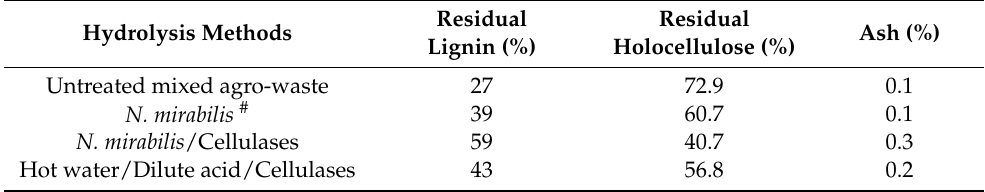
Table 3. Residual lignin and holocellulose content of the untreated N. mirabilis plant digestive fluids/cellulases and hot water/dilute acid/cellulases hydrolysed agro-waste composite samples. Hydrolysis Methods